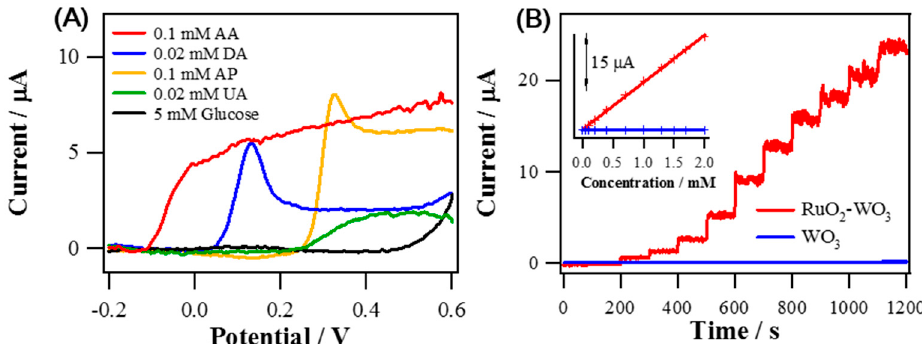
Figure 5. ( A ) Background-corrected LSVs of RuO 2 NRs-WO 3 NFs obtained in 0.1 M PBS (pH 7.4) independently containing one of 0.1 mM AA, 0.02 mM DA, 0.1 mM AP, 0.02 mM UA, 5 mM glucose (scan rate of 5 mV s − 1 ; and rotating speed of 1600 rpm). ( B ) Amperometric current responses of RuO 2 NRs-WO 3 NFs and WO 3 NFs for successive AA standard solution injections to increase the AA bulk concentration from 5 μ M to 2 mM in 0.1 M PBS (pH 7.4) with E app = 0 V (vs. S.C.E.). The inset: The calibration curves showing the current responses vs. concentration.